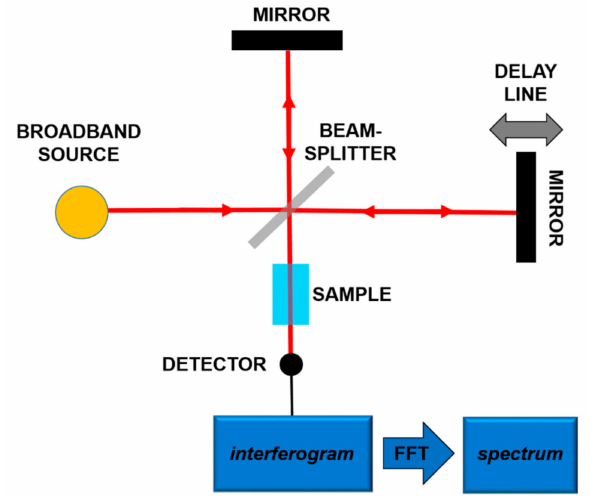
Figure 2. Principles of the Fourier-Transform Infrared Spectroscopy